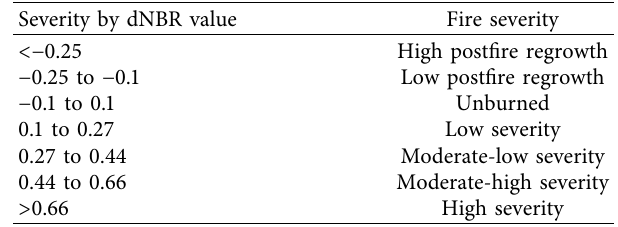
Figure 1: Map of the study area site in Banjarbaru. Table 1: The description of the dataset. Table 2: Severity by the dNBR